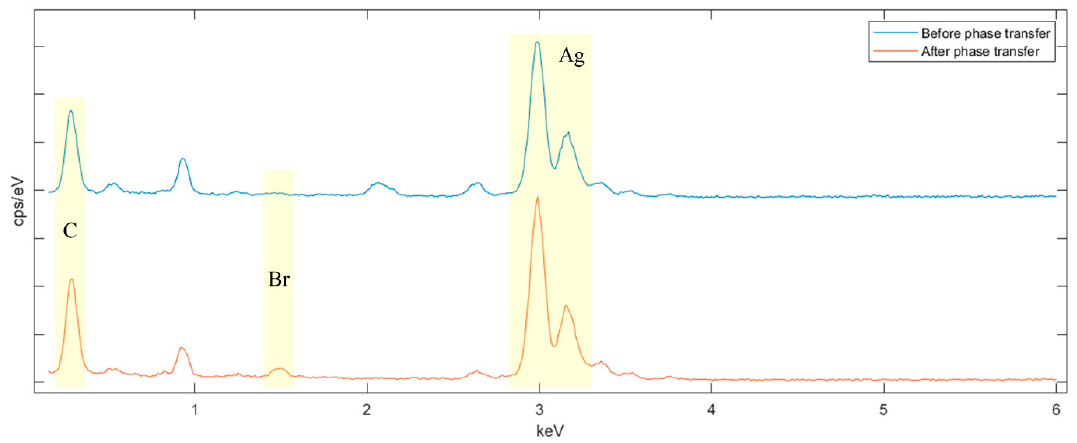
Nanomaterials 2019 , 9 , x FOR PEER REVIEW Figure 3. EDX spectra of AgNSs before / after phase transfer. Figure 3. EDX spectra of AgNSs before/after phase transfer.